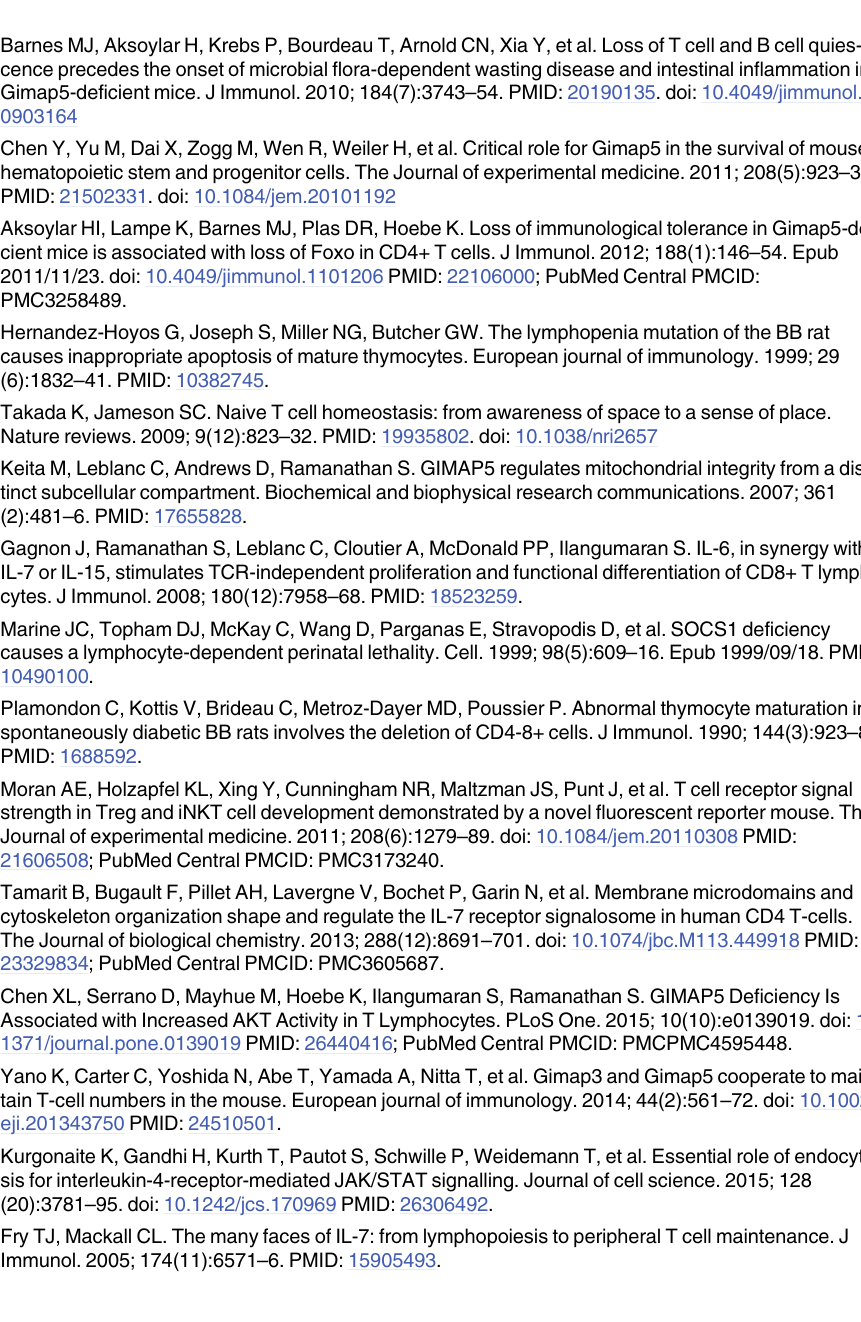
PLOS ONE | DOI:10.1371/journal.pone.0151837 March 29,